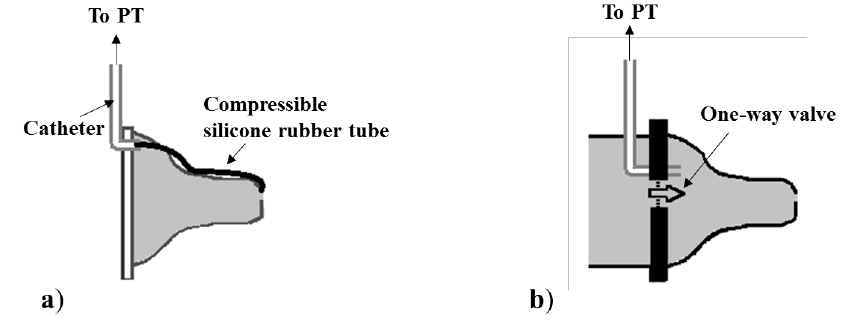
Figure 6. Sensing solutions for the measurement of the net pressure forcing the nutrient out of the nipple chamber. Two PTs are adopted to measure intranipple and intraoral pressure, and calculate the pressure gradient causing the nutrient to flow